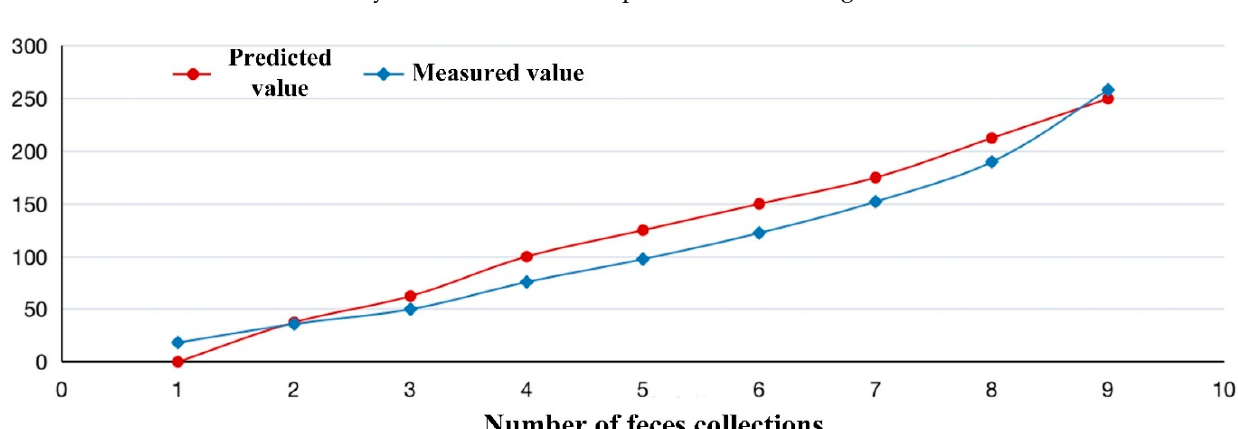
Figure 9. Defecation prediction in vivo experiment based on proposed LSTM model.